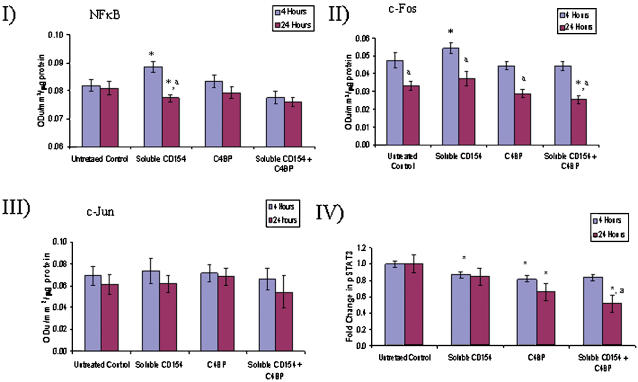
Densitometry Histograms showing changes in NFkB, c-Fos and c-Jun and pSTAT3 levels in response to sCD154 and C4BP stimulation determined using Western blotting (see figure 5). Changes in levels were assessed by densitometric analysis. These data show that the CD154/C4BP complex had no significant influence upon levels of NFkB or c-Jun, but did decrease levels of c-Fos at 24 hours compared with either unstimulated 24 hour control or the stimulated level observed at 4 hours. *p<0.05 a p<0.05These data show that stimulation of cells with CD154/C4BP complex resulted in a lower level of pSTAT3 which was sustained at 24 hours. *p<0.05 c.f. time point matched untreated control a p<0.05 c.f. treatment matched 4 hour time point.